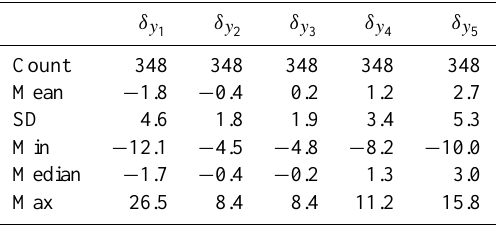
Table 1. Statistics of wake offset obtained with simple Gaussian tracking for a selected week. All values in lidar frame of reference are given in [m] except for the count.